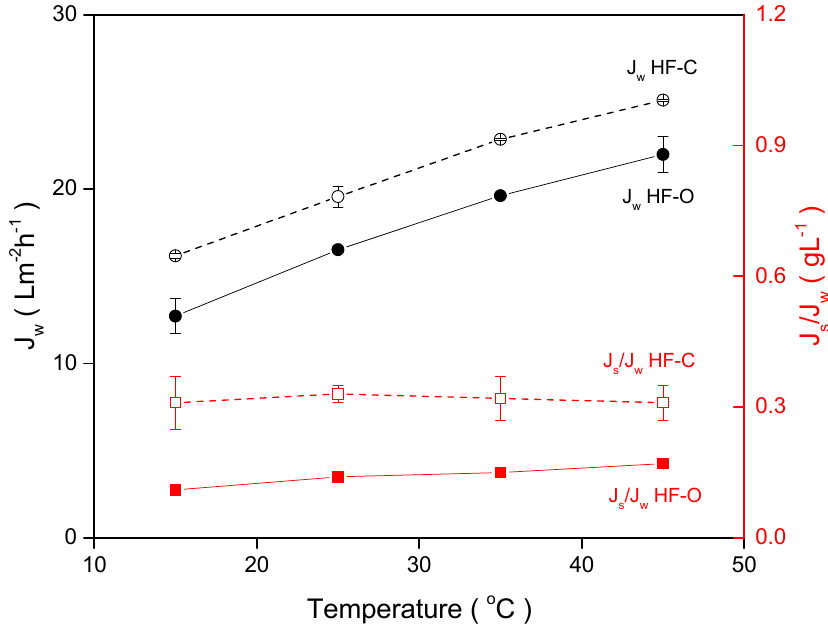
Figure 13. J w and J s / J w for HF–C and HF–O modules as a function of the DS and FS temperatures when DI water was used as an FS. The feed flow rate was 100 L · h − 1 , the draw flow rate was 25 L · h − 1 , the draw concentration was 1 M NaCl, and the TMP was 0.2 bar (n = 2).